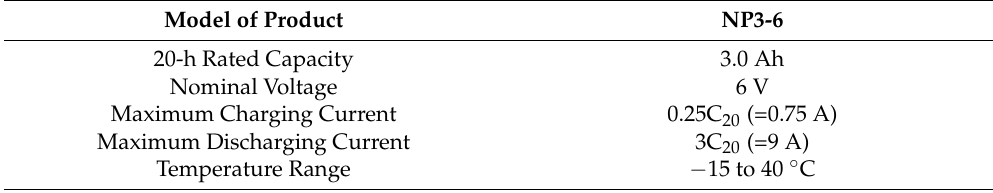
Table 3. Primary Specifications of the valve-regulated lead-acid battery.